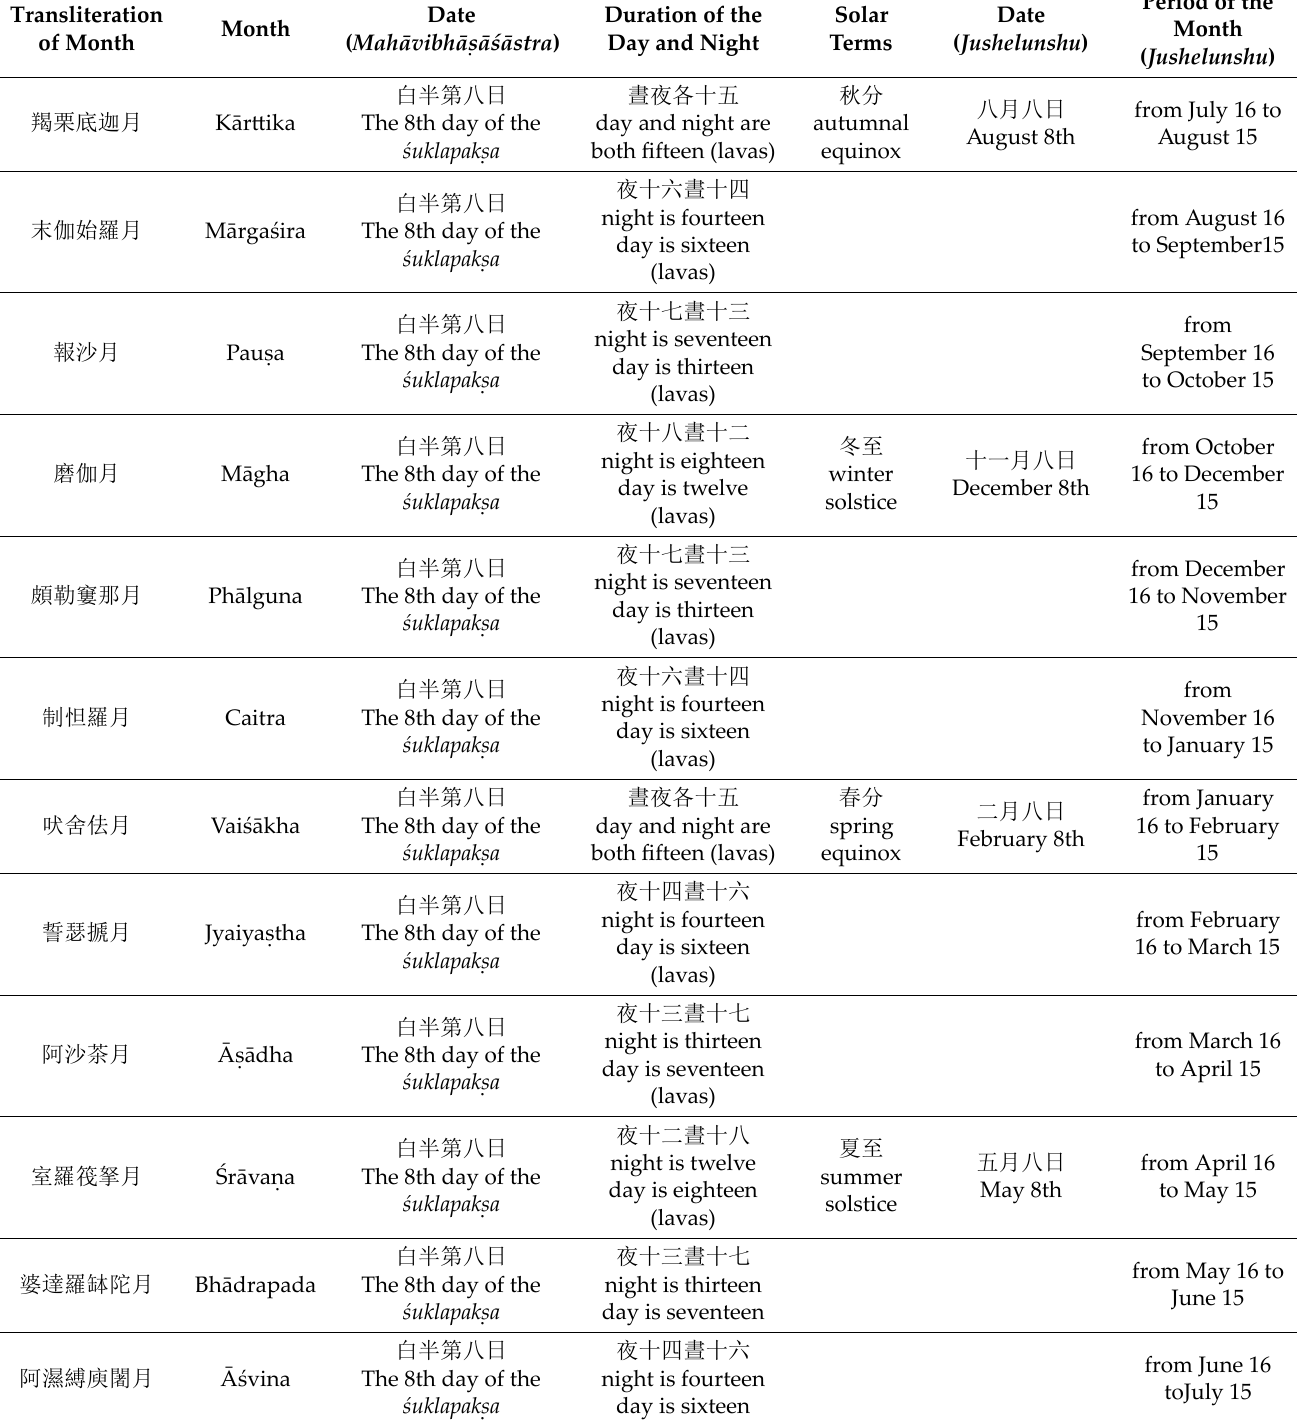
Table 4. The duration of the Indian day and night, and Chinese solar terms according to